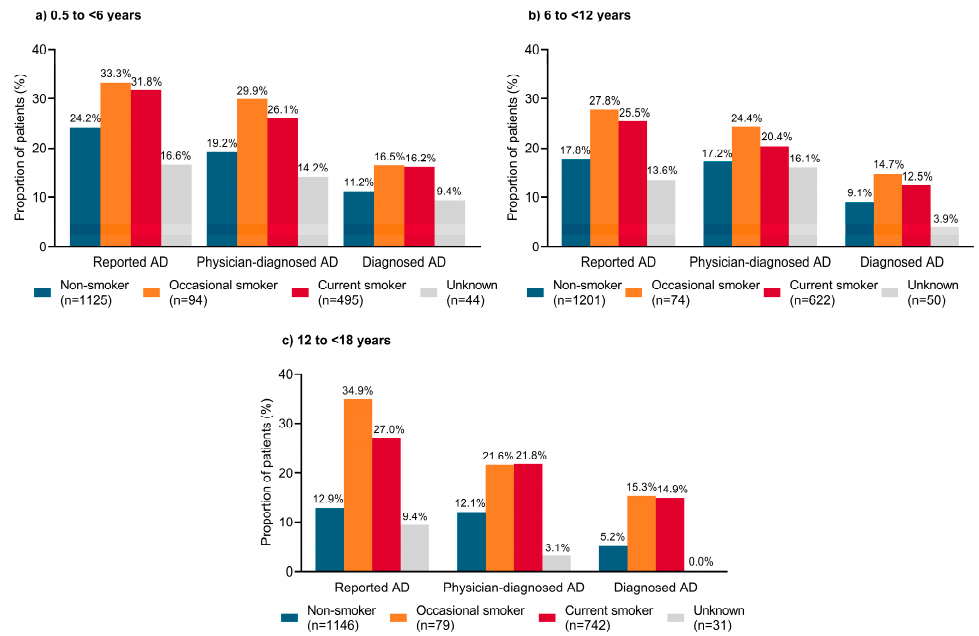
Figure 4. Prevalence of atopic dermatitis according to family smoking status in Japanese pediatric patients aged ( a ) 0.5 to <6 years; ( b ) 6 to <12 years; ( c ) 12 to <18 years. AD, atopic dermatitis.